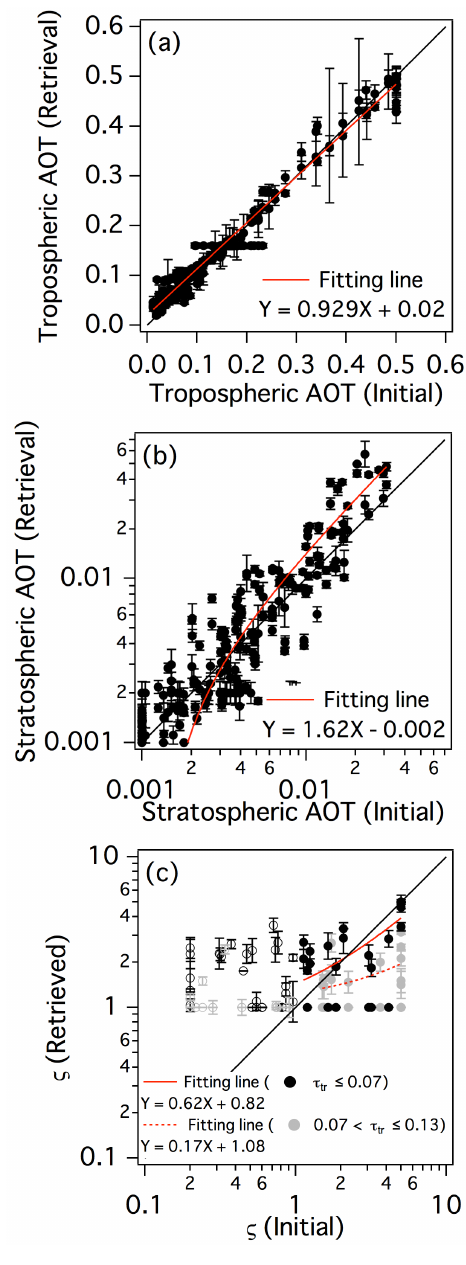
Figure 9. Initial and retrieved (a) tropospheric aerosol optical thick- ness, (b) stratospheric aerosol optical thickness, and (c) coarse–fine particle volume ratio ς in the retrieval-error analysis. Black and gray marks (circles) show ς retrievals with ς >1 ( ς ≤ 1) under very and moderately clean conditions,